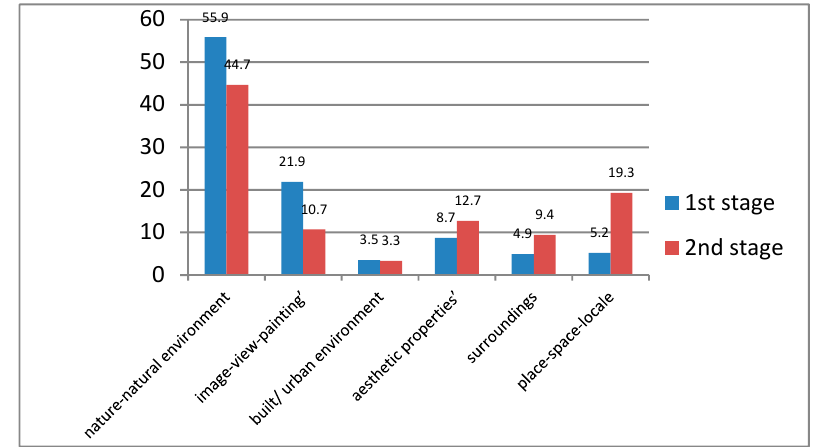
Figure 1. Greek engineering student landscape perception change, in answer to the question “what is your first thought when you hear the word ‘landscape’?”.